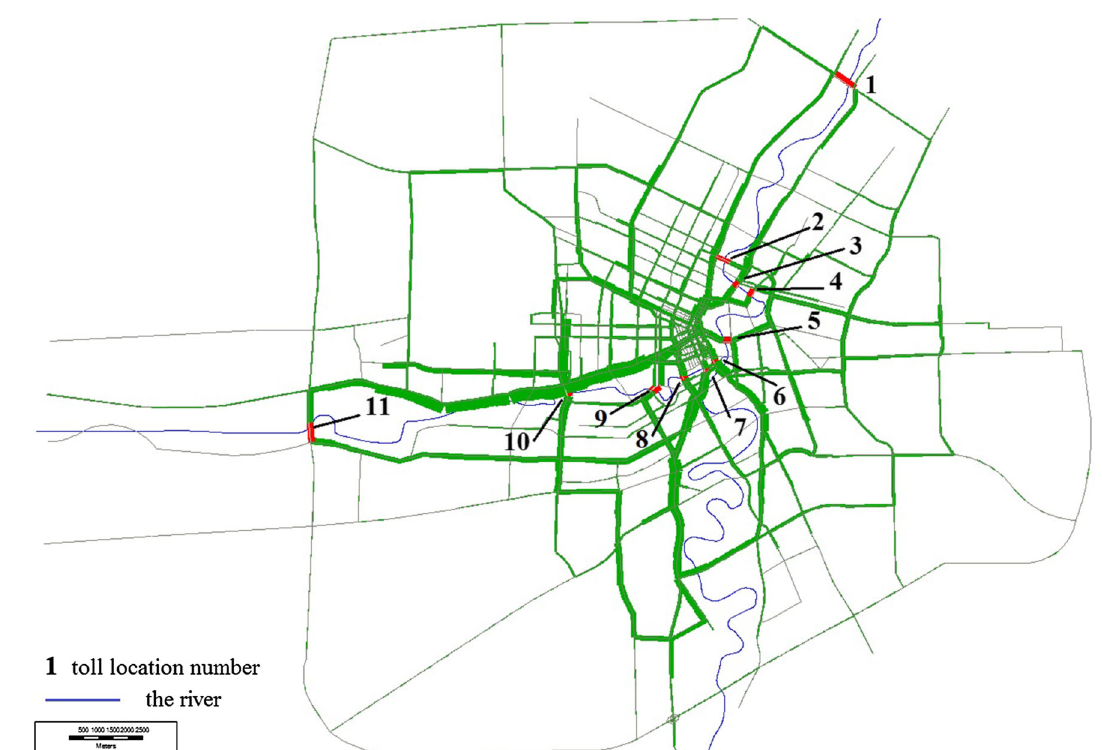
Figure 3b: No toll/subsidy, road 5 is closed